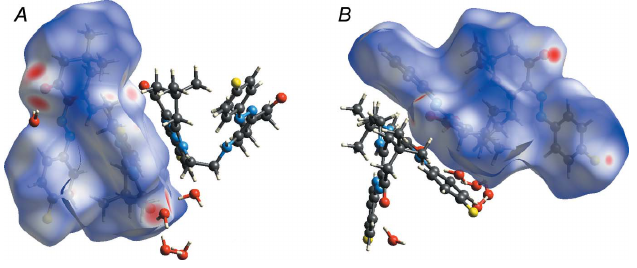
Figure 3 Hirshfeld surfaces of molecules A and B , mapped over d norm .